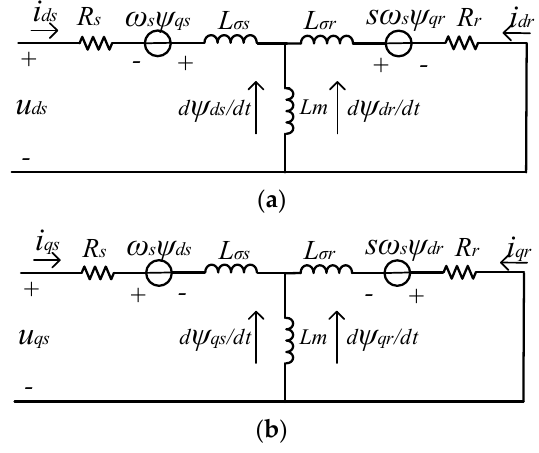
Table 1. Parameters of three-mass shaft model.